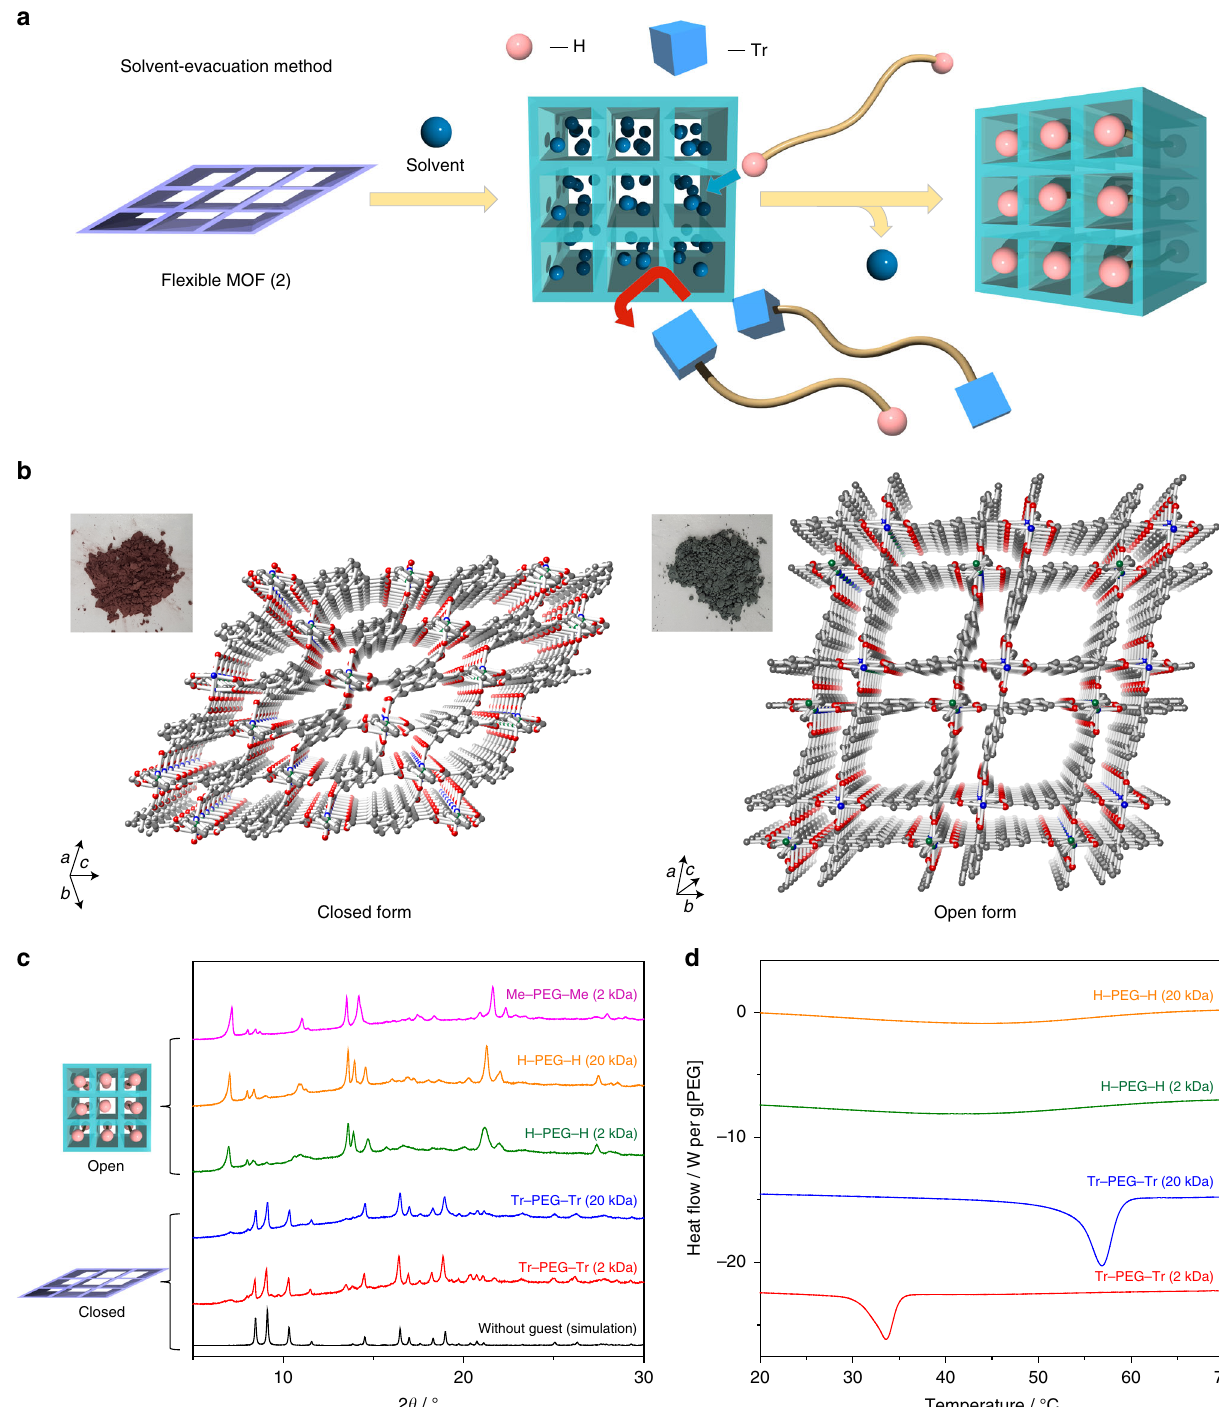
Fig. 2 Introduction of PEG into 2 using solvent-evacuation method. a Schematic for sorting polymers with different terminal groups using a fl exible MOF system (solvent-evacuation method). b Crystal structure and photograph of 2 (left: closed form, right: open form). c PXRD patterns of dried 2 , and 2 with PEG obtained by the solvent-evacuation method. d DSC pro fi les of 2 and PEG composites. The traces correspond to the fi rst cycle of the analysis, and samples were not thermally annealed before the